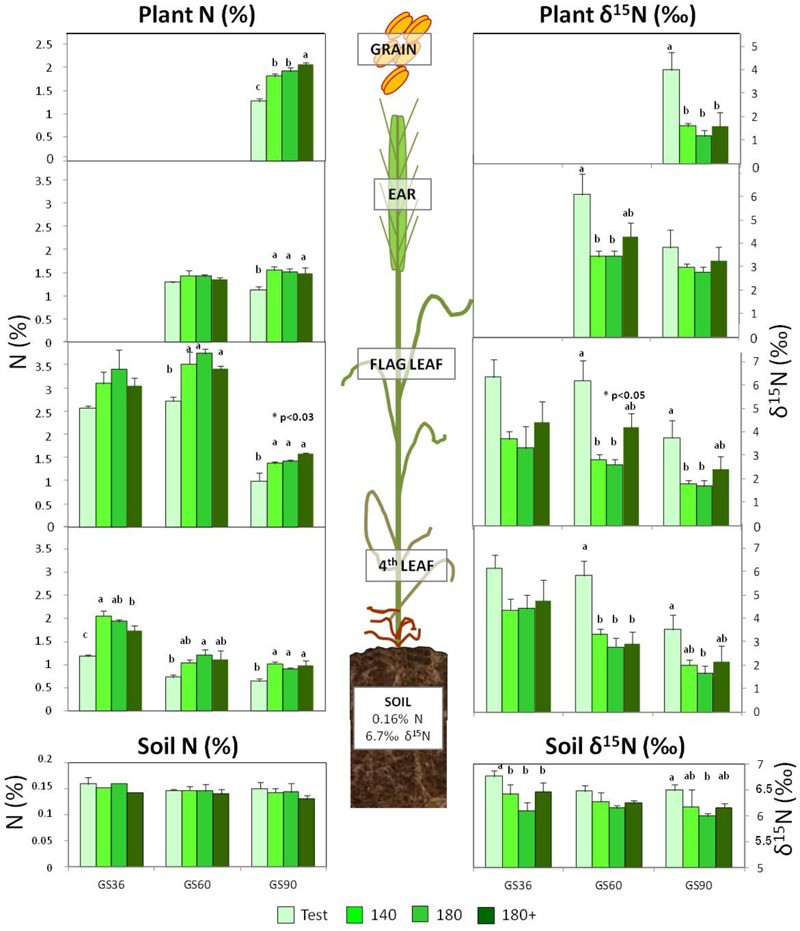
Effect of N fertilization on the N concentration and N isotopic composition (δ15N) of soil and plant organs at different growth stages. Fertilization treatments: 0, 140, 180, and 180+ (kg N ha-1) dispensed as indicated in Table 2. For each growth stage, different letters indicate significant differences between treatments at p < 0.05 according to Duncan’s test. Absence of letters indicates no differences. Asterisk indicates significant differences between treatments 180 and 180+, according to the t-test.